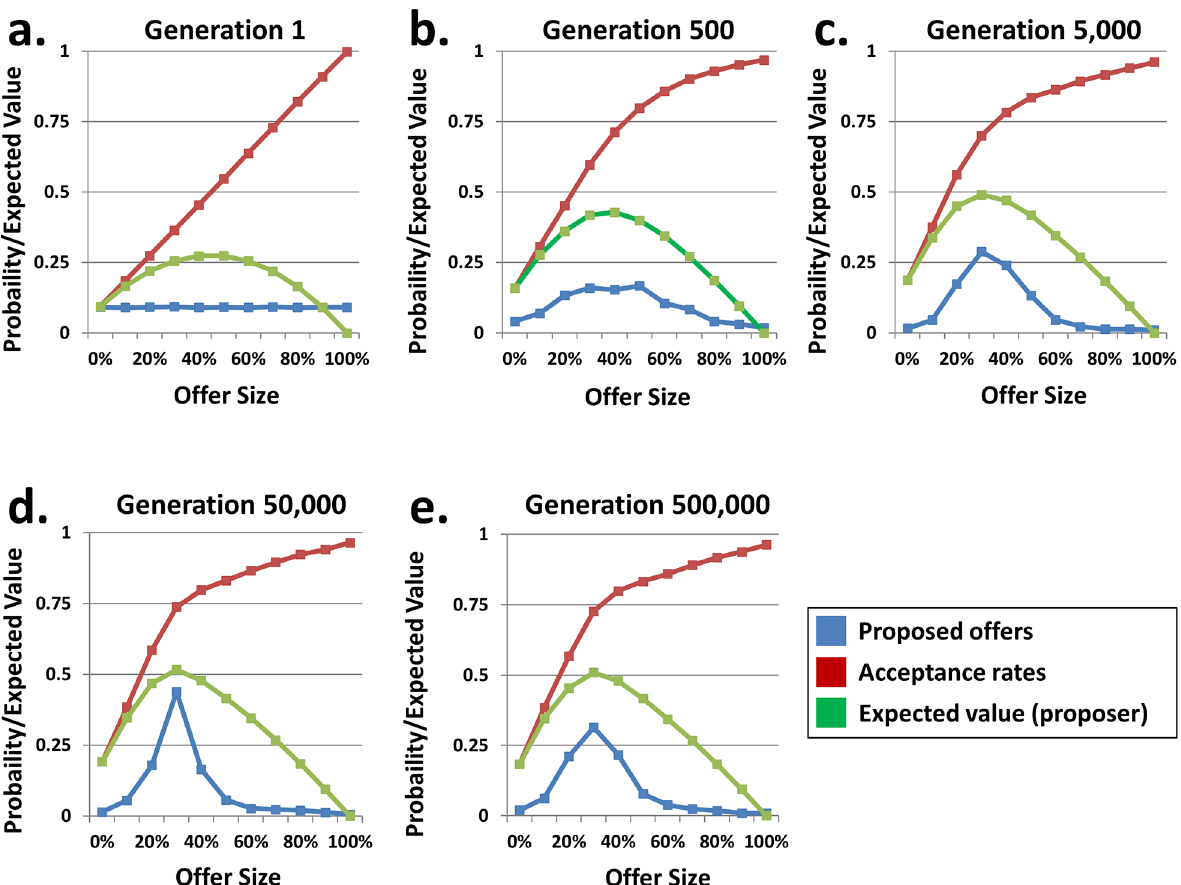
Fig 3. Co-evolution of offer frequencies and acceptance rates in monotonic populations with selection pressure. The lines in each panel show the mean genotype for proposers (blue line) and responders (red line) across the eleven possible offers for a population of size N = 100. The expected value of each offer, from the proposer ’ s perspective, is shown in green. When acceptance rates were constrained to monotonically increase over offer sizes, the highest expected value for proposers came from fair (or nearly fair) offers. As proposers and responders co-evolved, extremely high and extremely low offers ceased and proposers settled on a modal offer of 30% — the offer with the highest expected